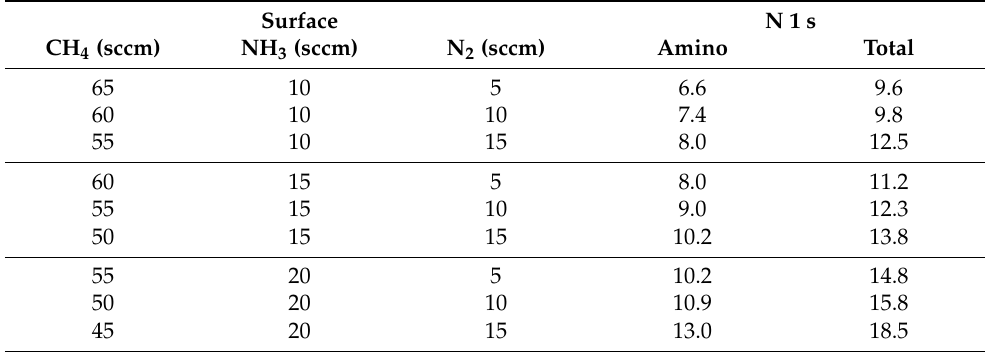
Table 5. Total and amino nitrogen (%) values quantified by XPS for surfaces plasma-coated in ternary CH 4 /NH 3 /H 2 mixtures (reported in columns named “surface”).